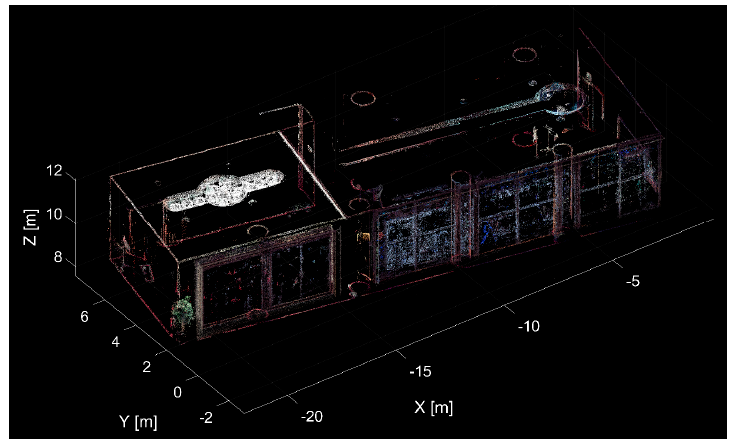
Figure 11. The remaining point cloud after plane and cylinder segmentation.